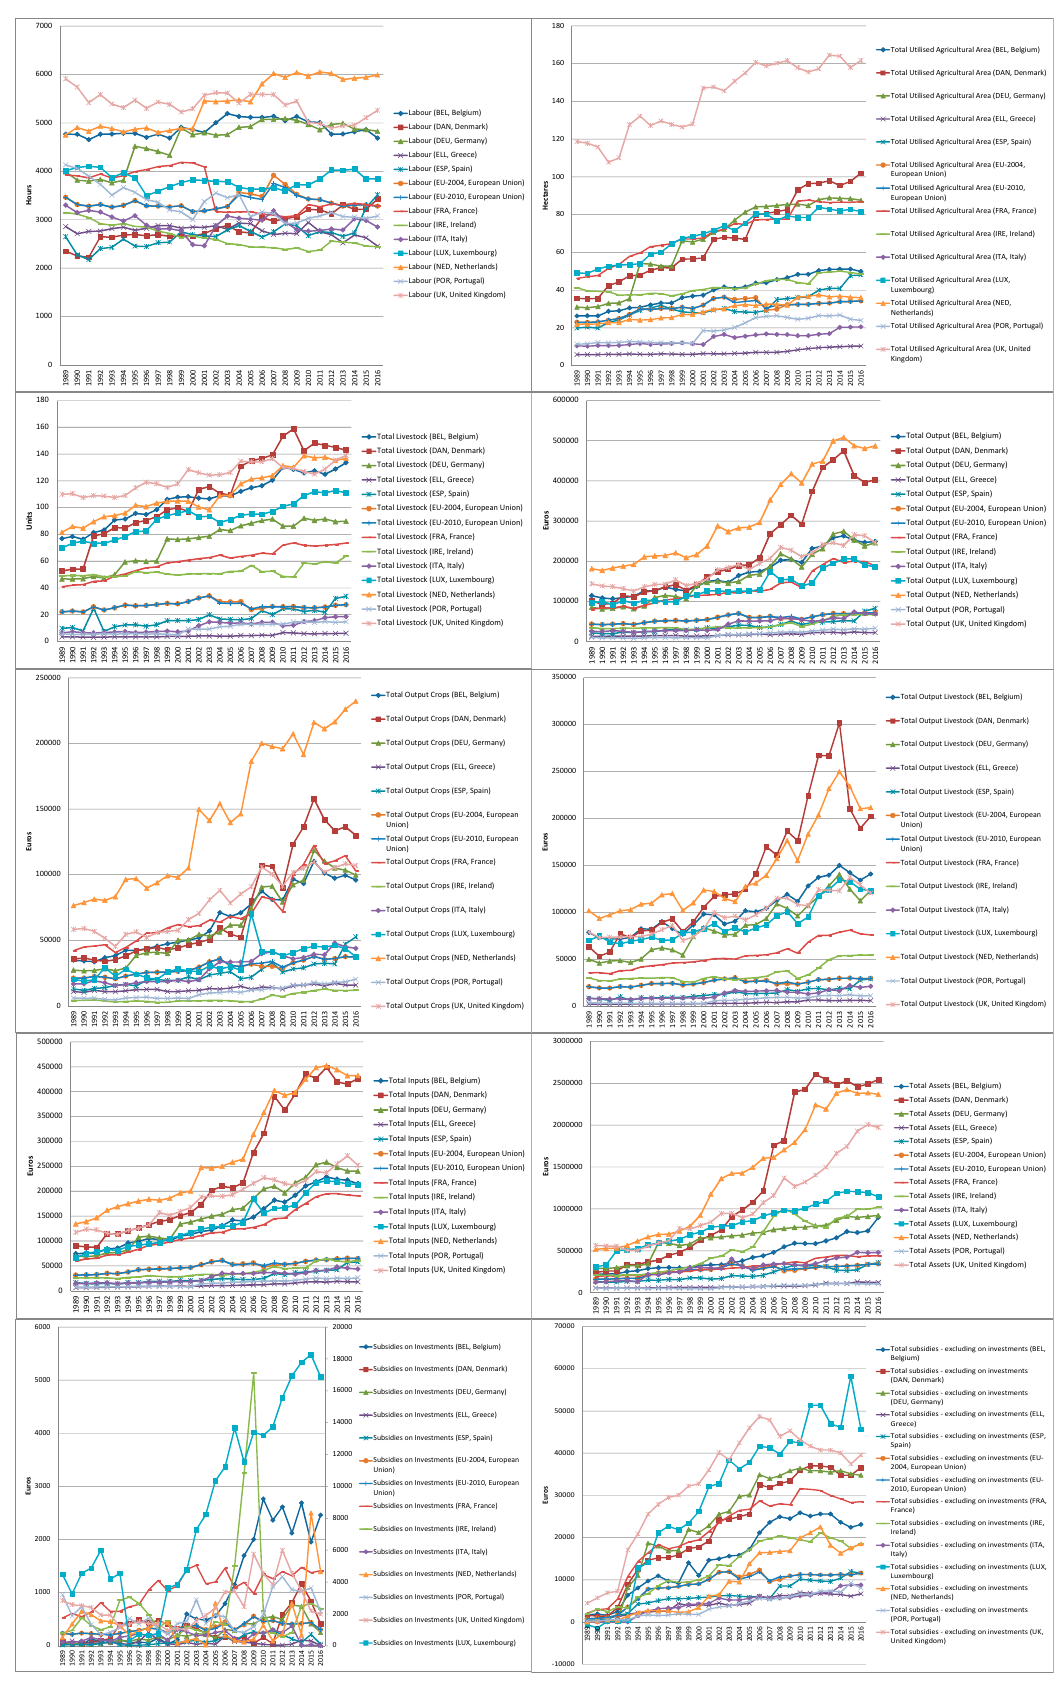
Figure 1. Evolution of several farm accountancy variables over the European Union countries (1989–2016).